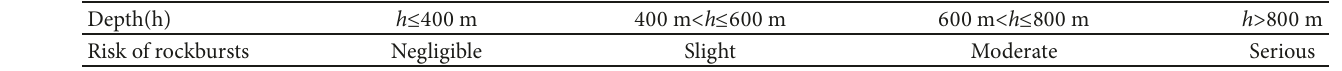
Table 1: Relationship between depth and rockburst risk.